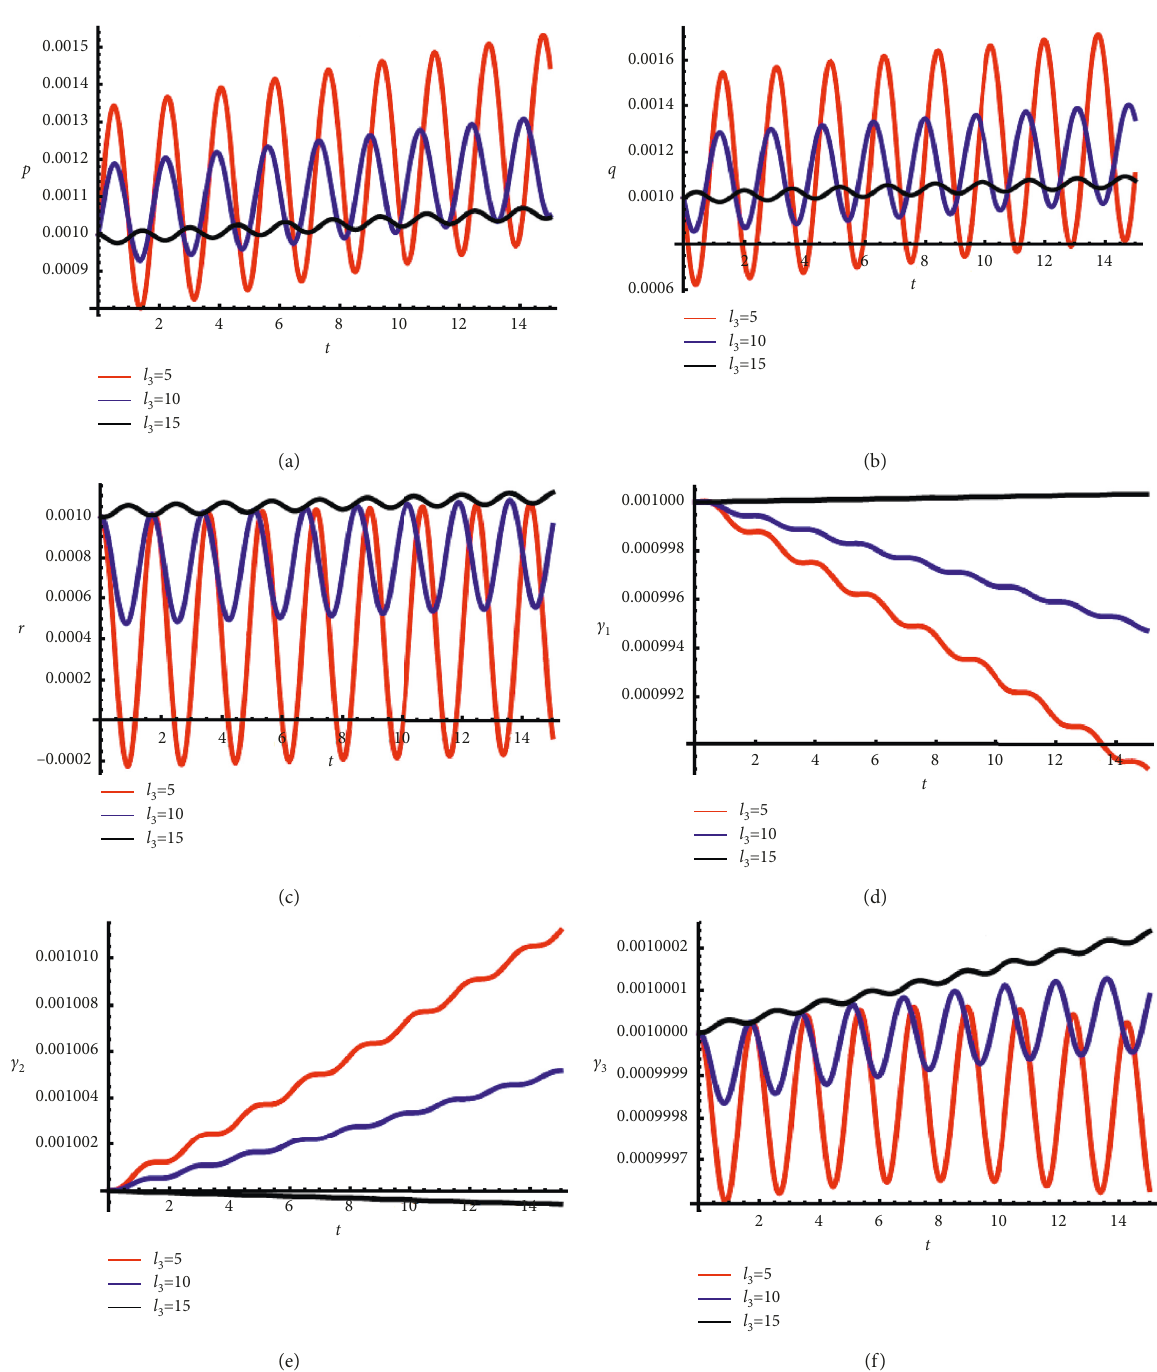
Figure 4: Time histories of the numerical solutions of p,q,r, c